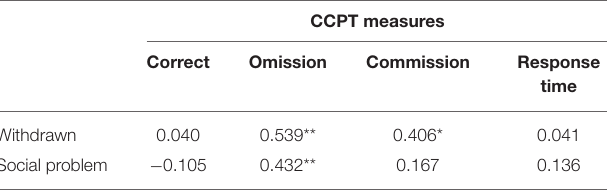
TABLE 3 | Correlation coefficients of the CCPT measures with the CBCL withdrawn and social problem subscale scores in the SCT